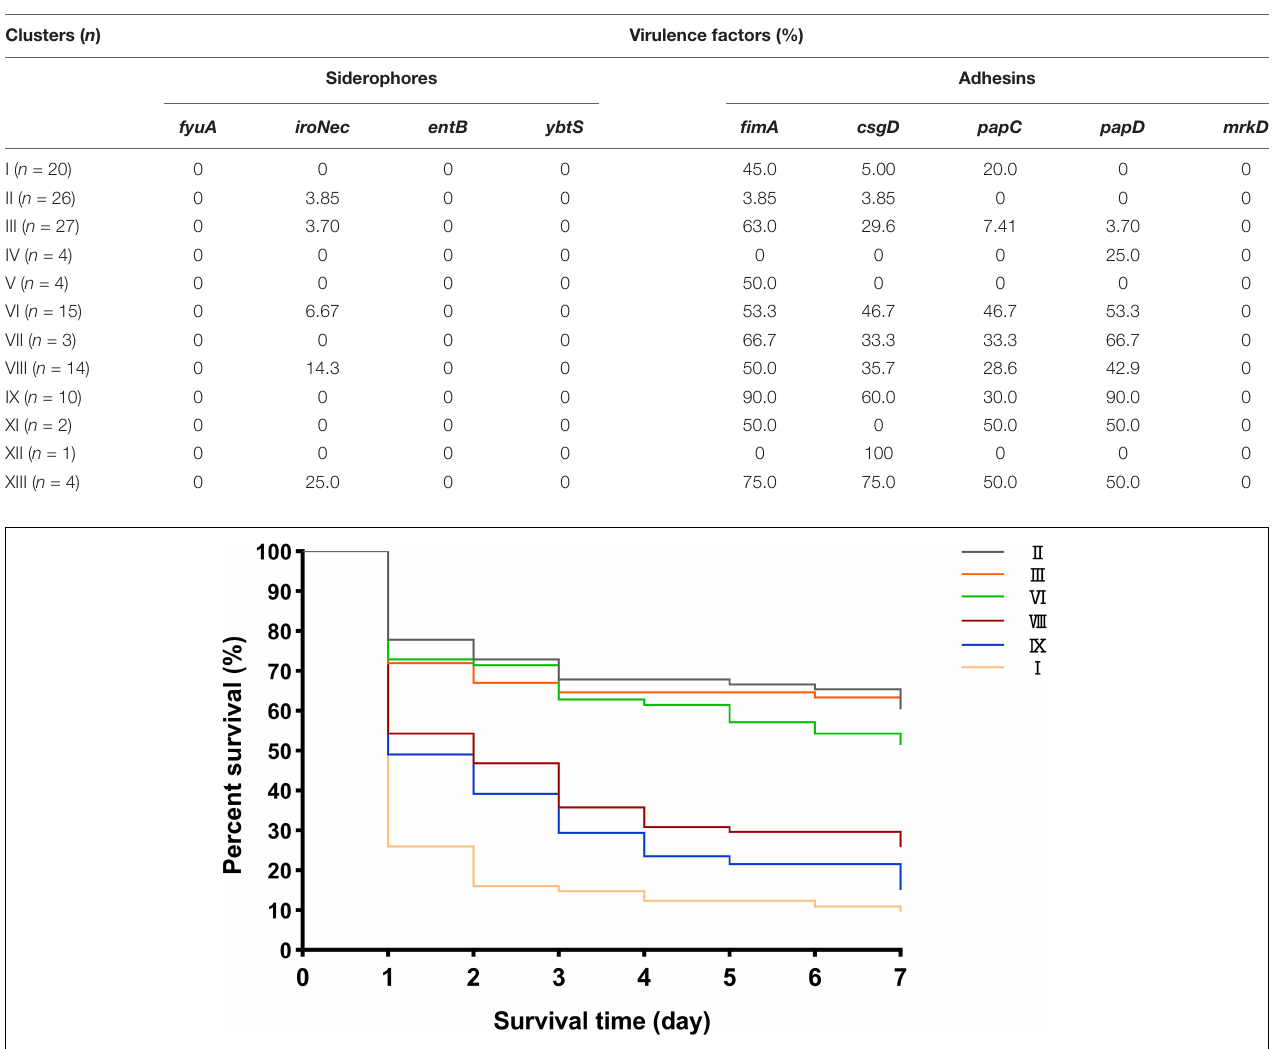
TABLE 1 | Carrying rates of virulence-related genes between different clusters.